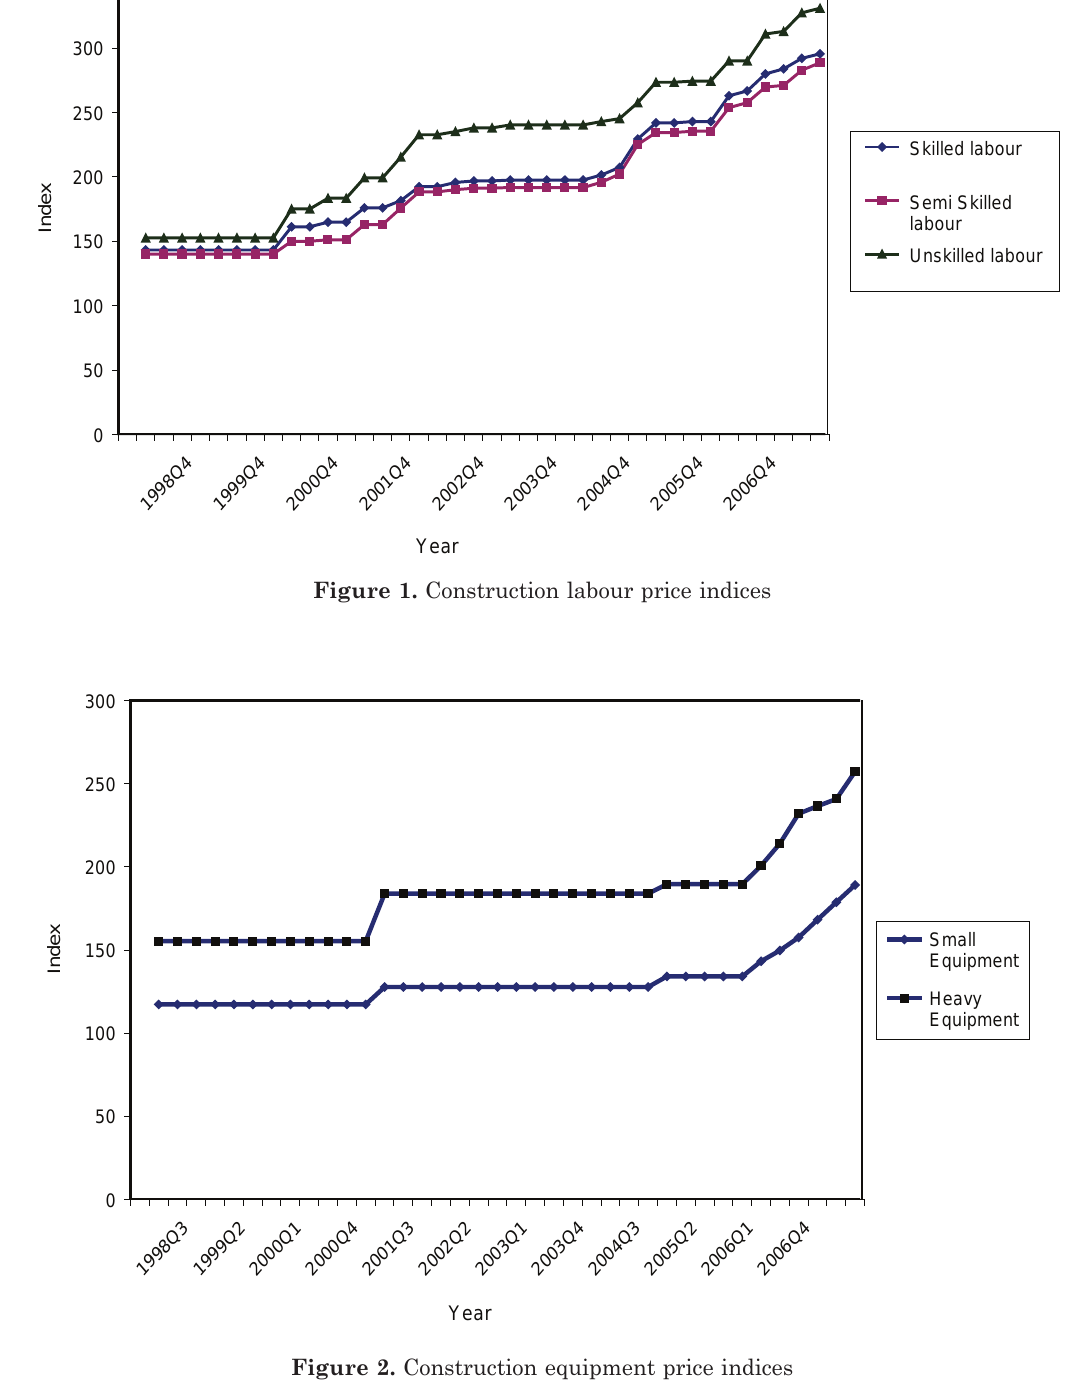
Figure 2. construction equipment price